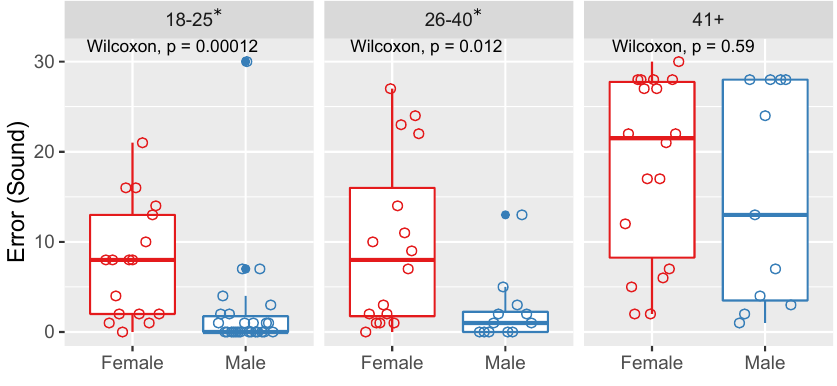
Figure 8. Boxplots comparing age groups of males and females regarding errors in ”Sound” condition. Significant differences are marked with asterisk. R = 0.35, p = 0.014 R = 0.59, p = 9.6e-06